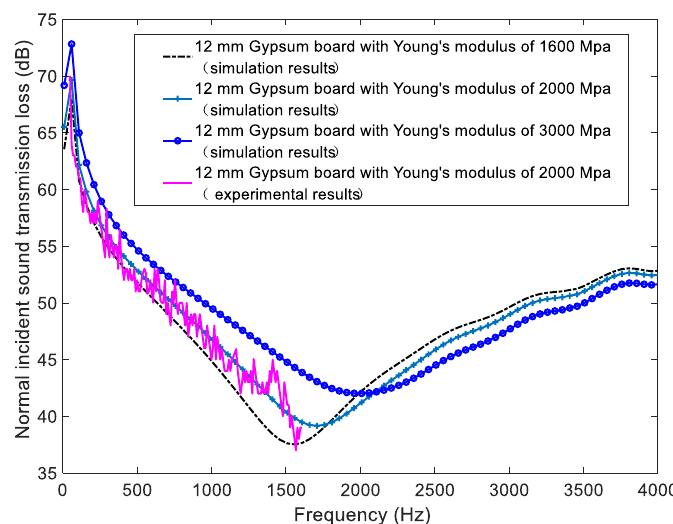
Figure 5. The STL spectrum of the change of Young’s modulus with the set range.